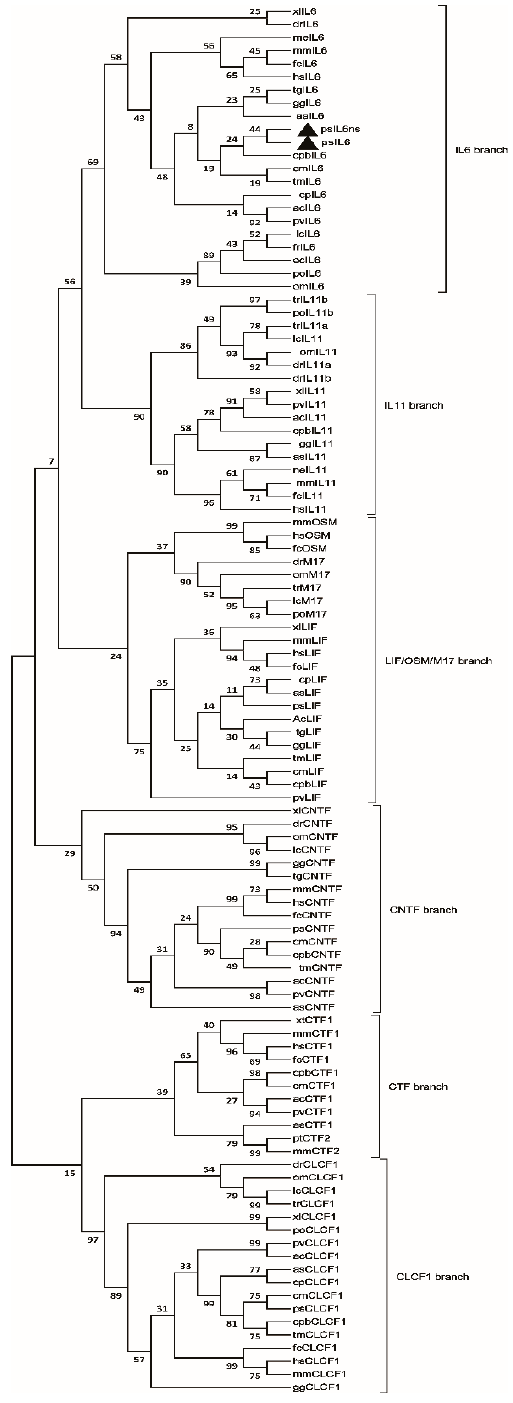
Figure 3. Phylogenetic tree showing the relationship between the turtle IL6 gene and genes of IL6 families in other selected vertebrate species. The phylogram was constructed on MUSCLE and MEGA X. The neighbor-joining method was used. Johns–Taylor–Thornton model with Gamma value of 1.676610112 and bootstrap values of 1000 replications were adopted. Accession numbers are supplied in Supplementary Figure S4. psIL6 and psIL6ns are labeled with a filled square.